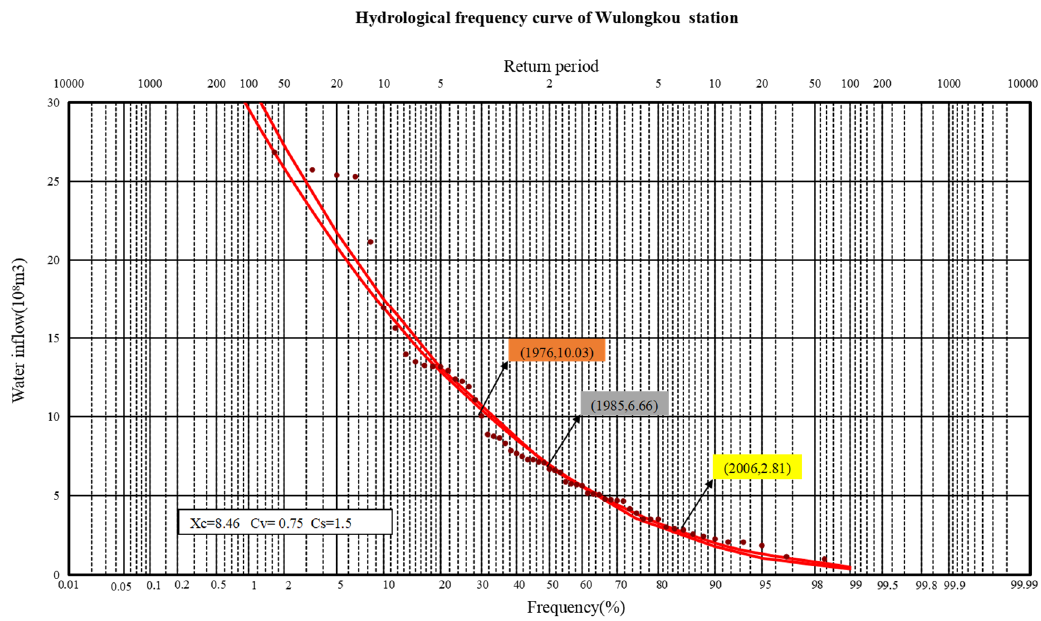
Figure 5. Hydrological frequency curve of Wulongkou hydrological